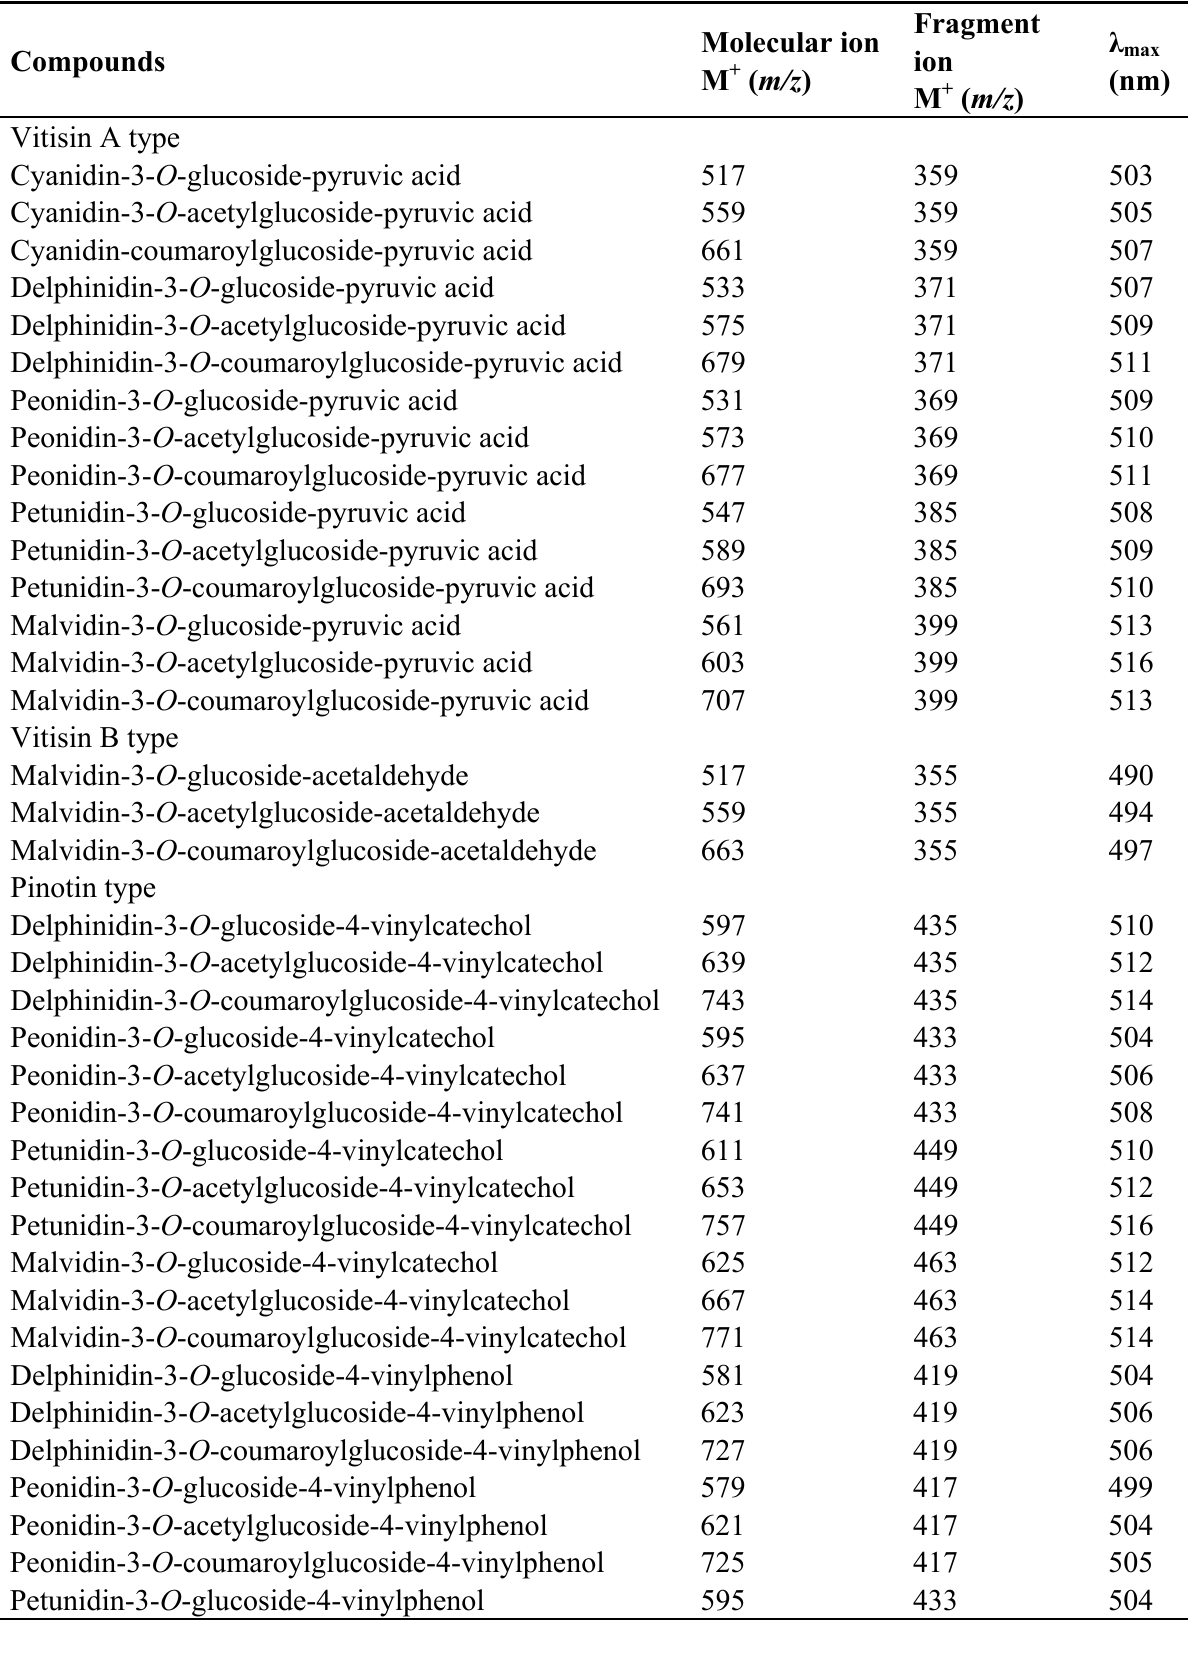
Table 1. The mass spectral and UV-vis data of some major pyranoanthocyanins that can be detected in various aged red wines